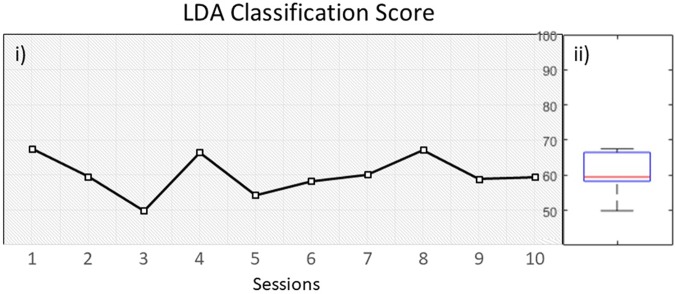
(i) LDA classification performance over time within 10 sessions, (ii) distribution of performance.